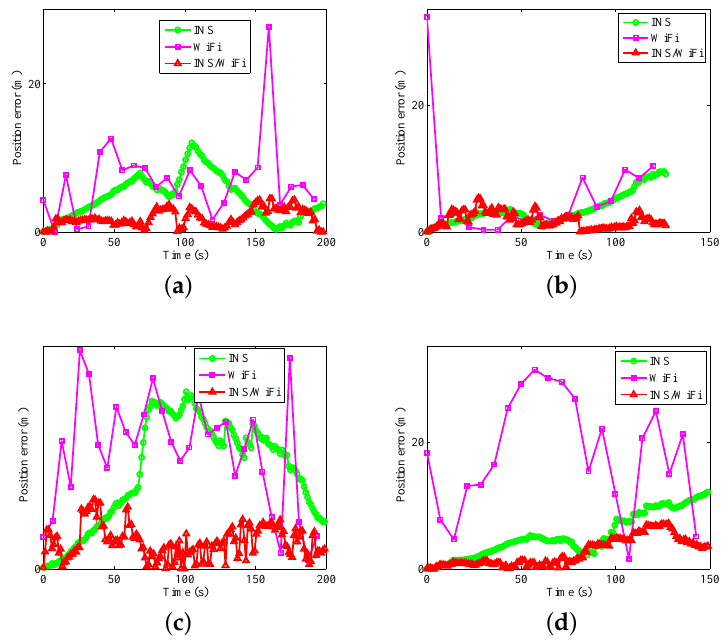
Figure 8. Position errors with different gestures: ( a ) calling; ( b ) dangling; ( c ) handheld; and ( d )